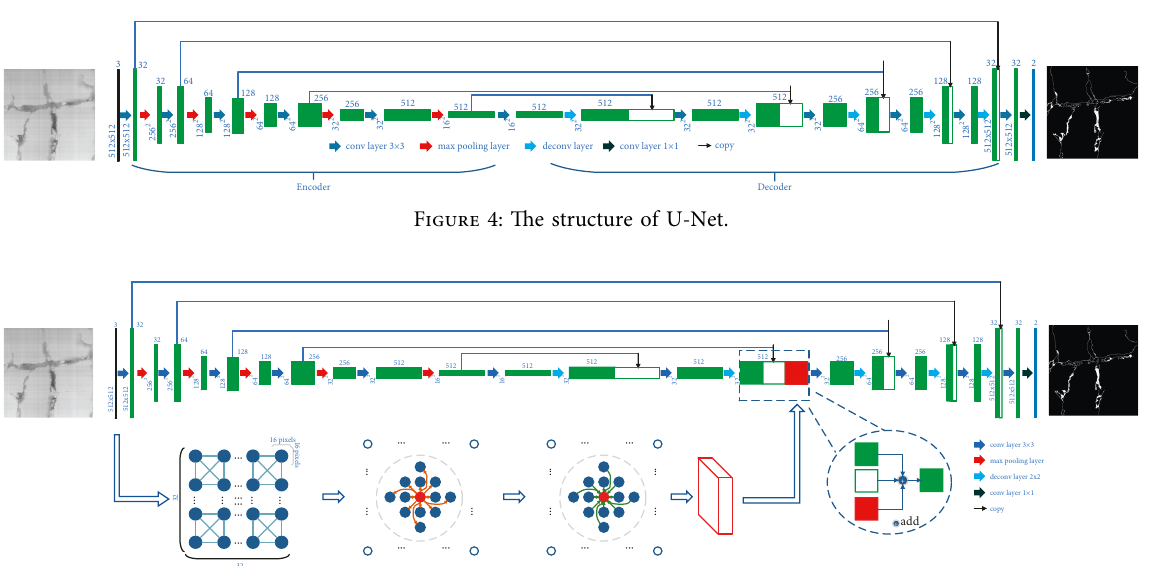
Figure 5: The structure of the whole network. The top-line describes the processing of the image in the U-Net. The number above the feature map presents the number of channels. The number beside the feature presents the size of the feature map. The following line describes the processing in the graph neural network branch. And the feature map in the U-Net and the graph network branch are fused after the first